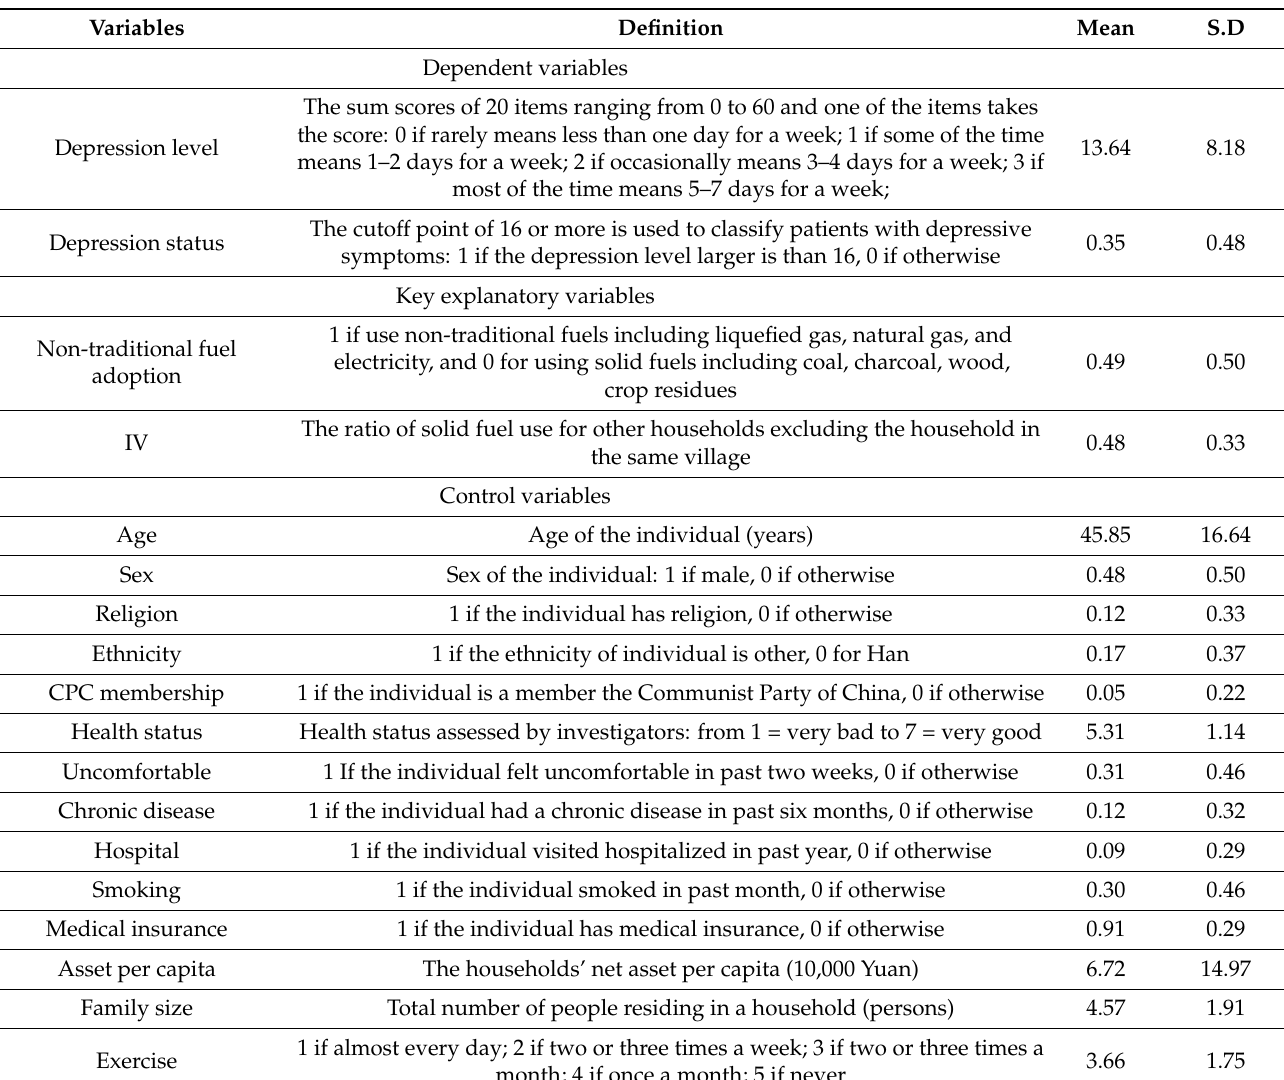
Table 1. Variable measurements and descriptive statistics of